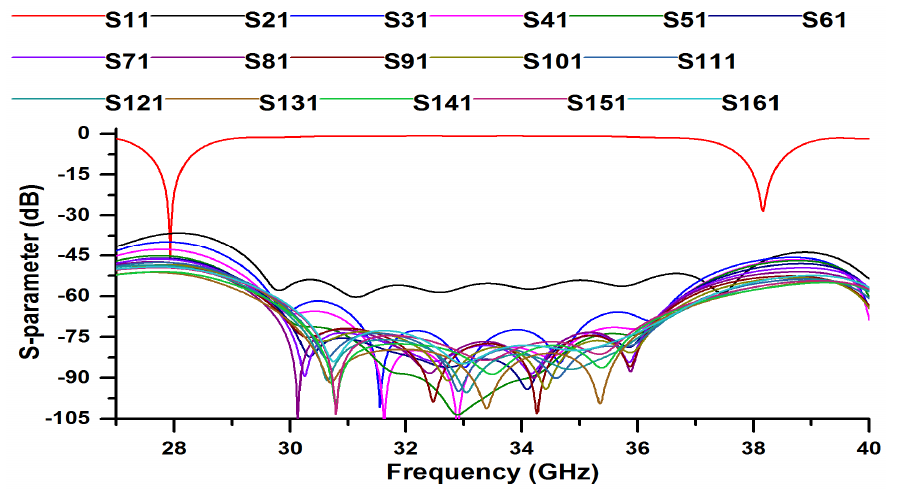
Figure 8. The S-parameters of the array antenna.